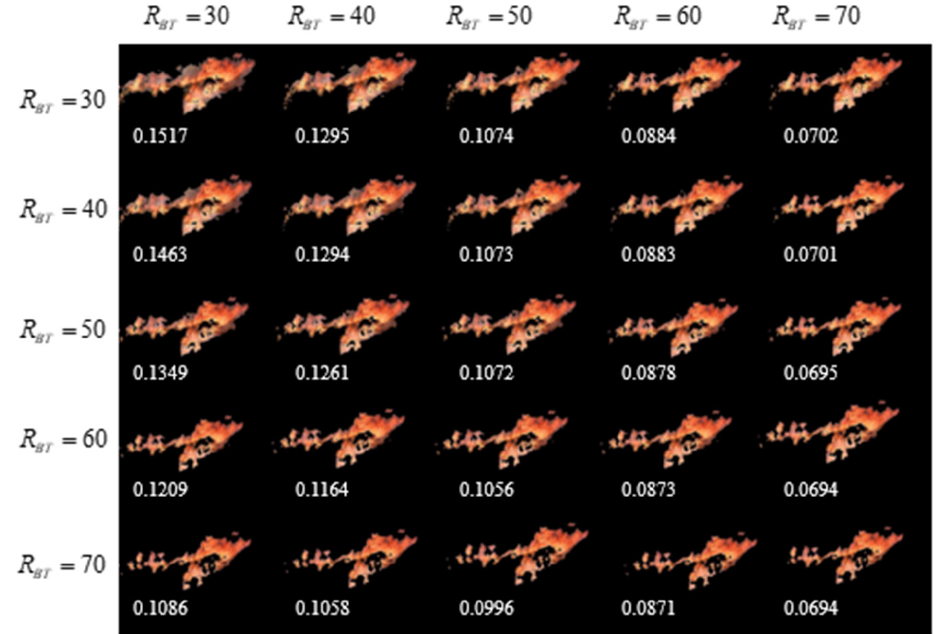
Figure 2. Pixel retention rate of different R GT and R BT (thresholds).